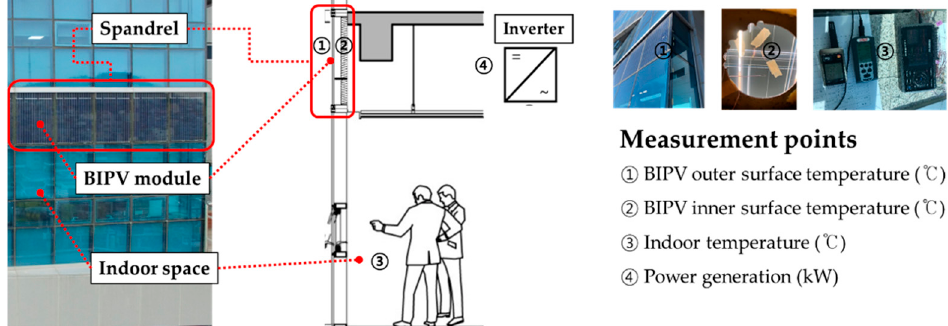
Figure 3. Measurement locations for BIPV modules installed on the spandrel of the target building.